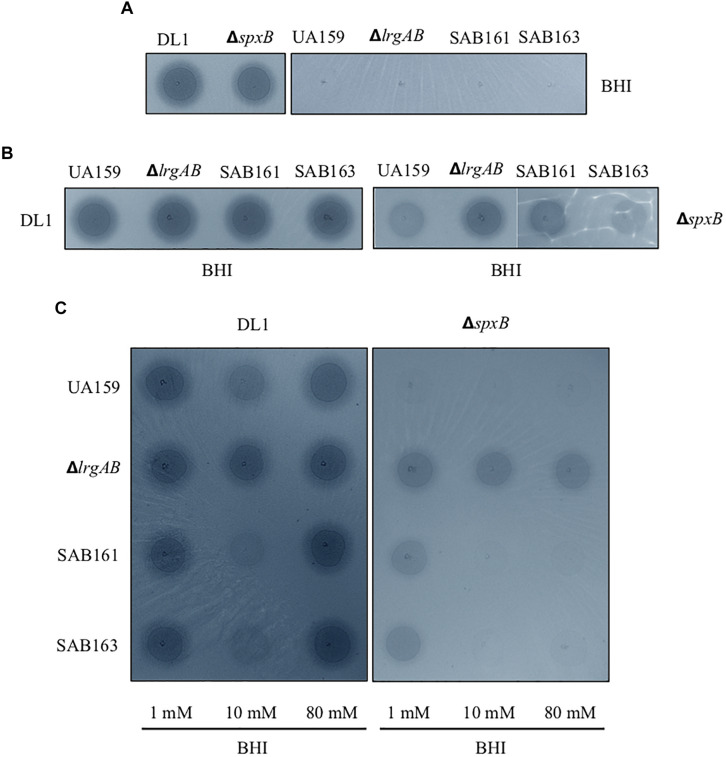
Dual-species competition assays between S. mutans lrg-derivative strains and S. gordonii DL1, or ΔspxB. The lrg-derivative strains include S. mutans UA159 (WT), ΔlrgAB (lrgAB-deficient), SAB161 (lrgAB-overexpressing), and SAB163 (lytST-overexpressing). Each S. mutans strains was cultured singly (A) or together in competition with either S. gordonii DL1 (left panels of B and C) or ΔspxB (right panels of B,C) in plain BHI medium (A,B) or in BHI medium supplemented by 1, 10, and 80 mM exogenous pyruvate (C). All cultures were for 24 h at 37°C in an aerobic atmosphere, and then was inoculated on Prussian blue agar plates. After an additional 24 h, the growth and blue precipitation zone were observed and analyzed with VisionWorks® software. All images were subjected to identical color balancing settings in Adobe Photoshop as described in section “Materials and Methods.”